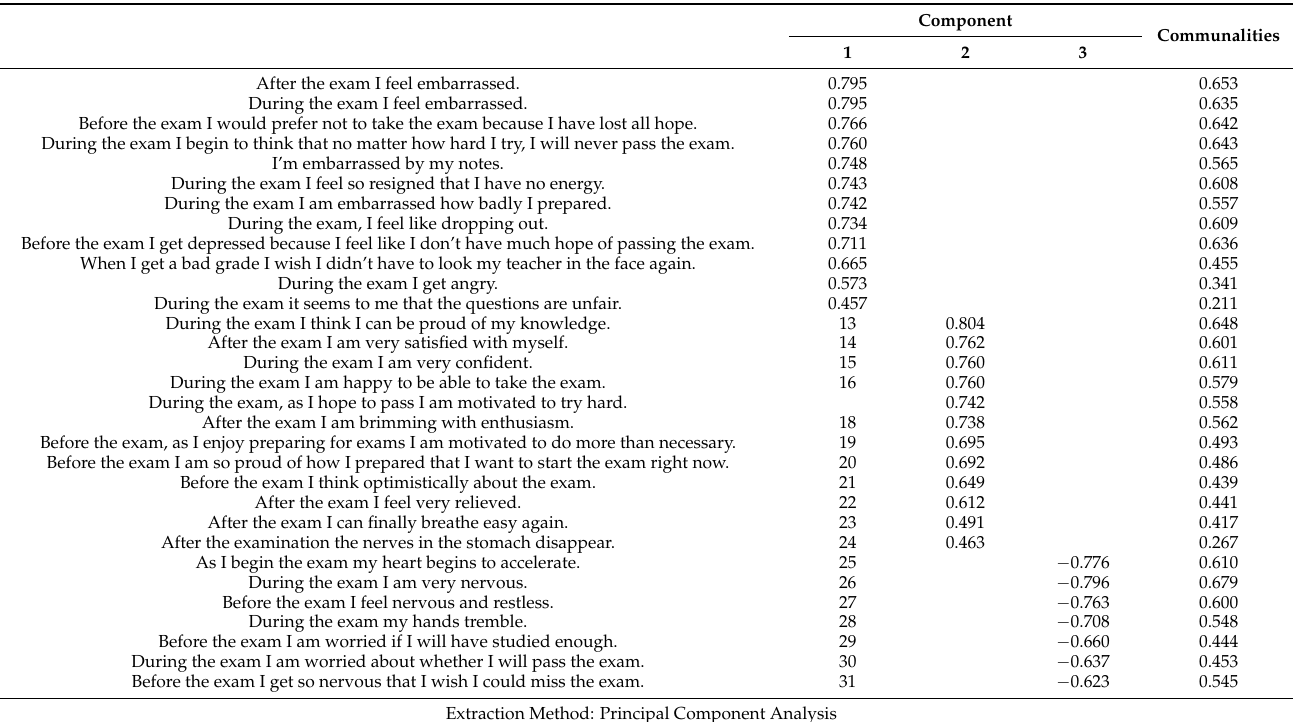
Component Communalities 1 2 3